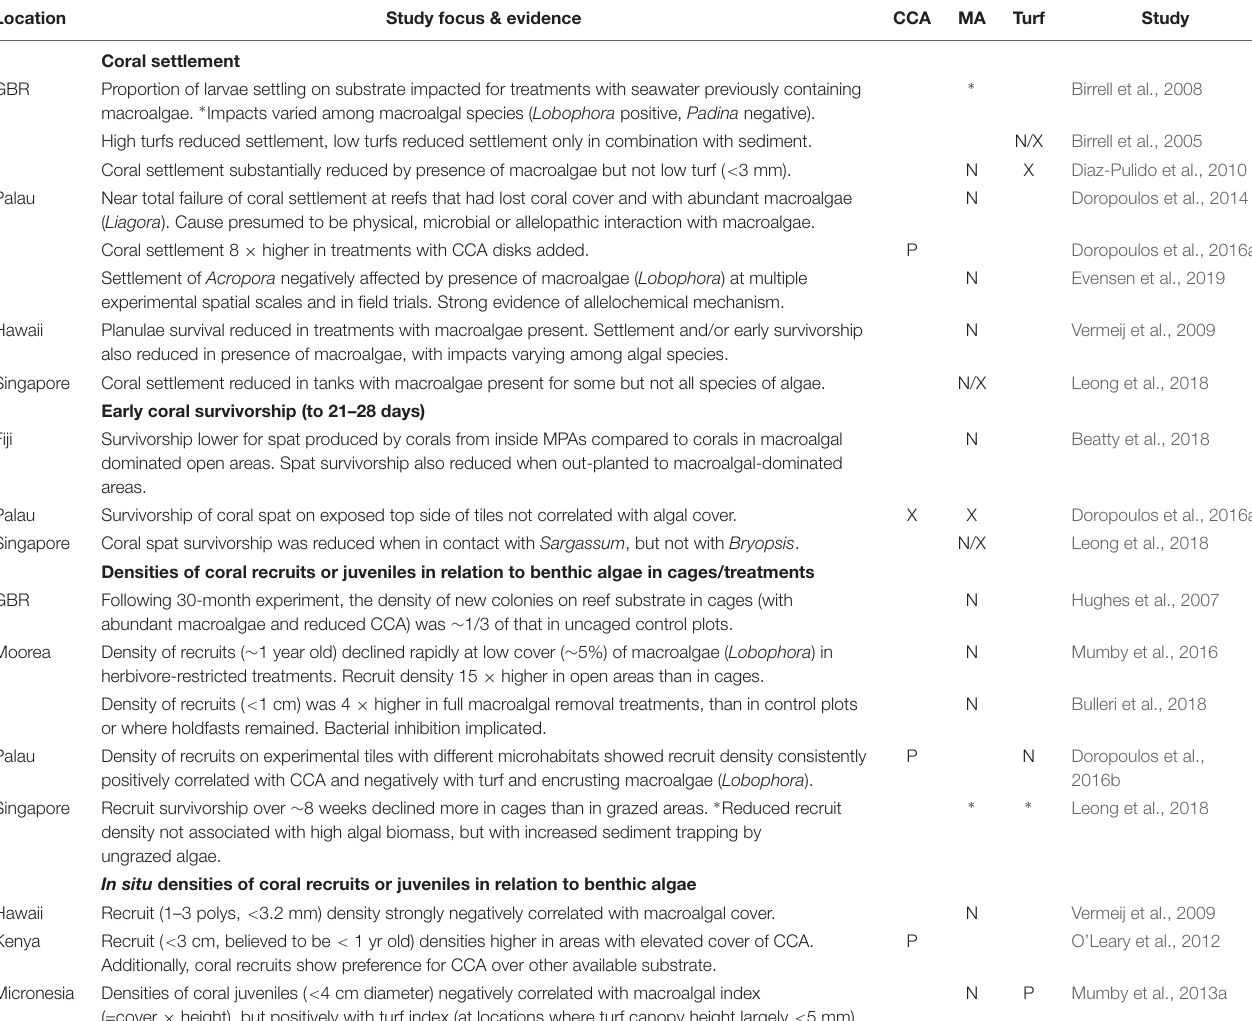
TABLE 2 | Effects of benthic algae on coral replenishment – i.e., settlement, survivorship or density of early life stage corals.